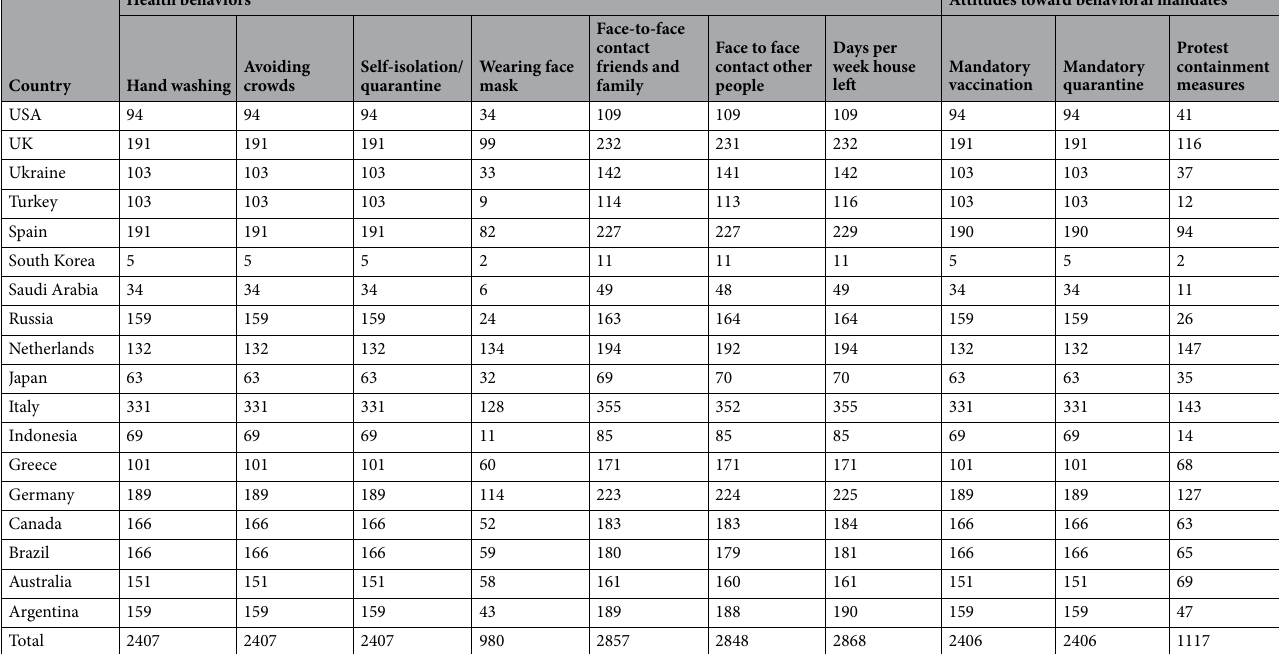
Table 3. Observations per country for health behaviors and attitudes toward behavioral